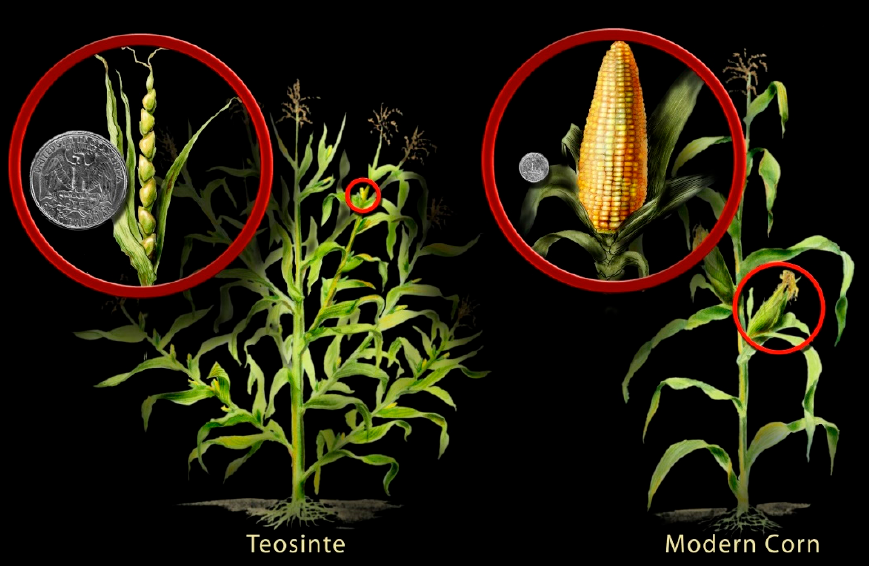
Figure 2. Domestication promotes rapid phenotypic evolution through artificial selection. Pictured here is wild grass teosinte ( Zea mays ssp. parviglumis ) that was domesticated into modern maize ( Z. mays ssp. mays ). The main traits selected during domestication included the ear and seed size (compared in relation to a USD coin in the inset) and the suppression of axillary branching. Figure courtesy National Science Foundation, USA.